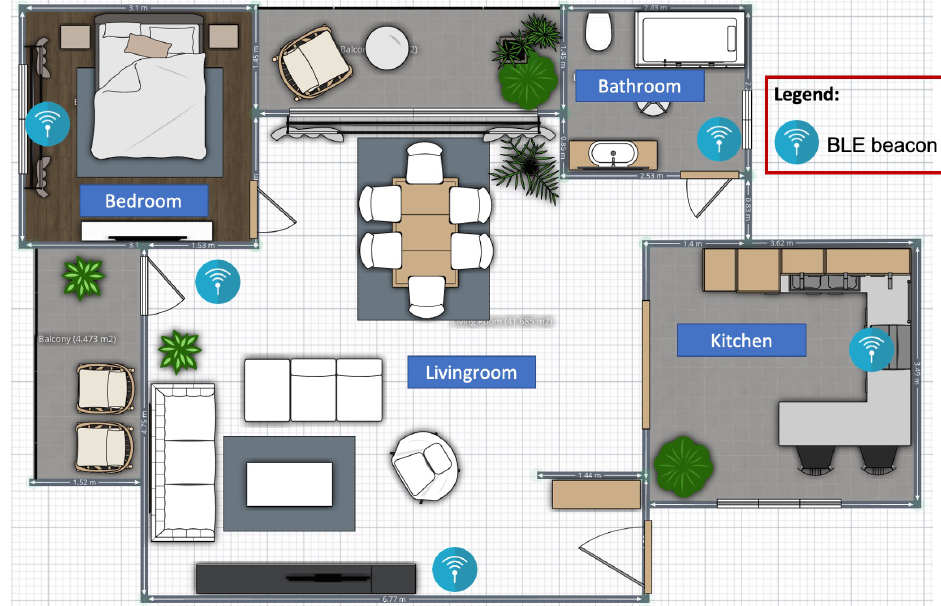
Figure 29. Example of indoor environment with one or more BLE beacons for each